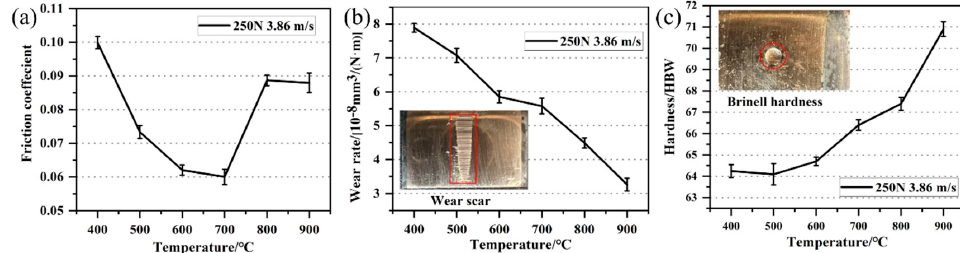
Figure 4. Copper layers properties. ( a ) Friction coefficient; ( b ) wear rate; and ( c ) Brinell hardness.